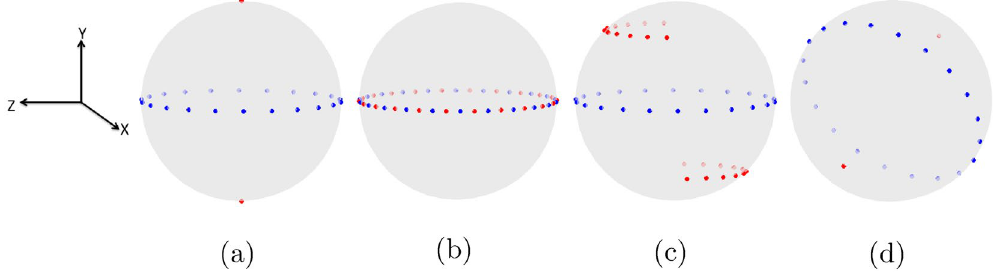
Figure 2. Spherical representation of acquisition schemes. Please note that in all these images, the sample can be imagined as being stationary at the center of the sphere while the setup rotates around it. Blue points represent the vectors ± t ( x ) and red points represent ± s ( x ) for all x ∈ A (0, 0, 11) with ( a ) horizontal grating alignment, ( b ) vertical grating alignment, and ( c ) diagonal grating alignment. ( d ) The vectors ± t ( y ) and ± s ( y ) for all y in an exemplary acquisition scheme Y ( q , [0.7071, − 0.7071, 0] T , 10) obtained using the method explained in Algorithm